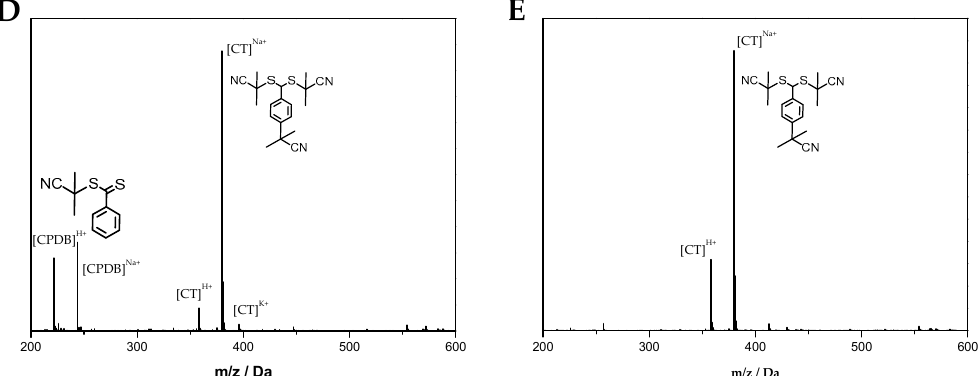
Figure 5. NMR and MS analysis of ( A ) Isolated CPDB RAFT agent ( B ) Isolated re-aromatized para terminated cross-termination product ( C ) HETCOR NMR analysis of the isolated re-aromatized para terminated cross-termination product ( D ) ESI-MS analysis of the crude reaction mixture and ( E ) ESI-MS analysis of the isolated re-aromatized para terminated cross-termination product.